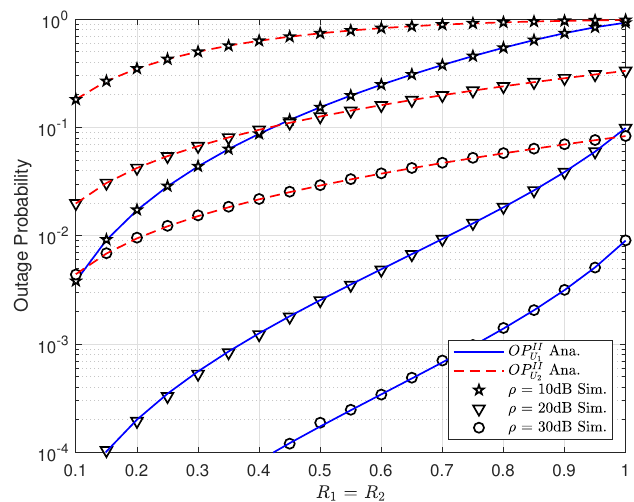
Figure 8. Outage performance of U 1 and U 2 versus the target rate R 1 = R 2 .